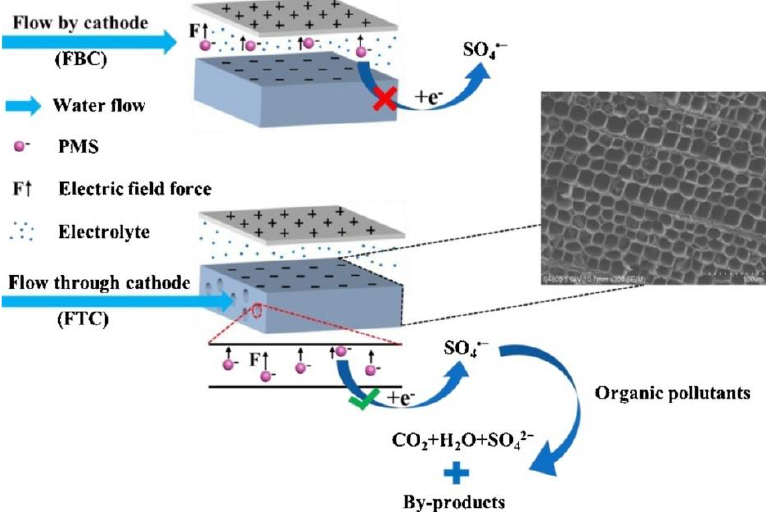
Figure 6. In flow-through cathode (FTC), the mechanism of the decomposition of peroxymonosulfate (PMS) and yield of radicals. Reprinted with permission from ref. [129]. Copyright 2020 Elsevier B.V.